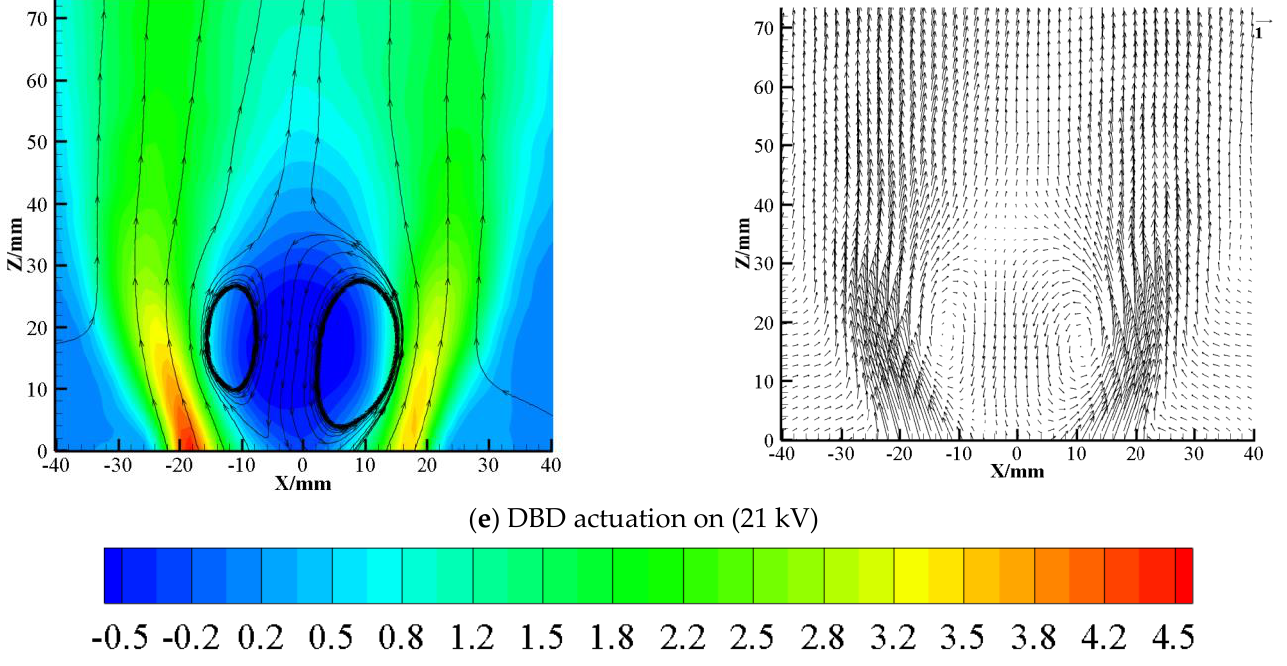
Figure 3. Contours of mean axial velocity magnitude, streamlines, and vectors (left: magnitude contours and streamlines; and right: vectors) in the XZ plane with bulk velocity of 3 m/s.